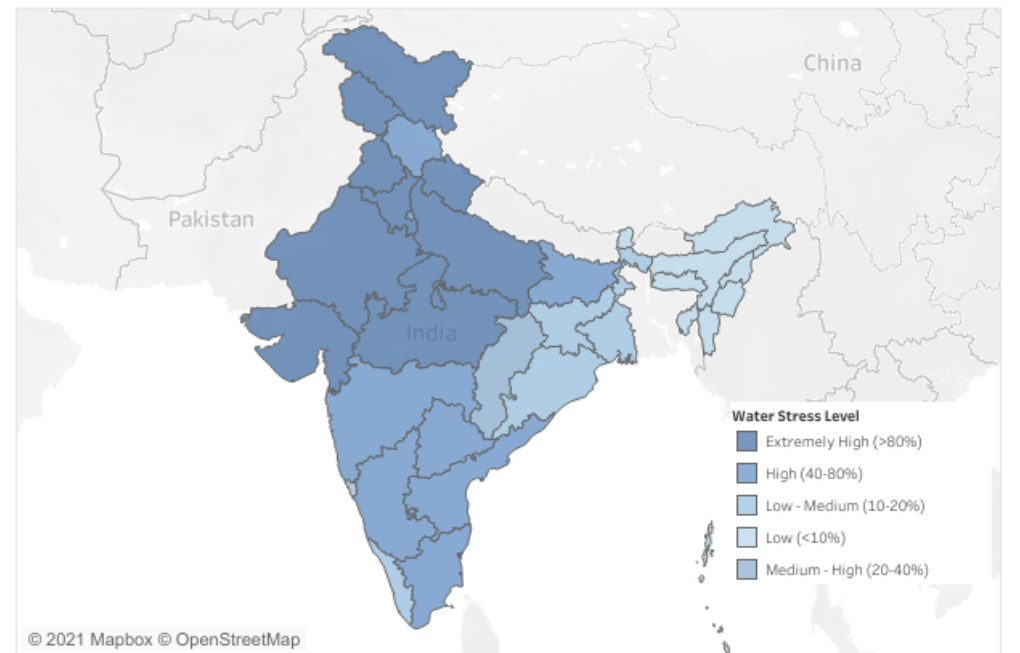
Scheme 1. State-wise distribution of water stress in